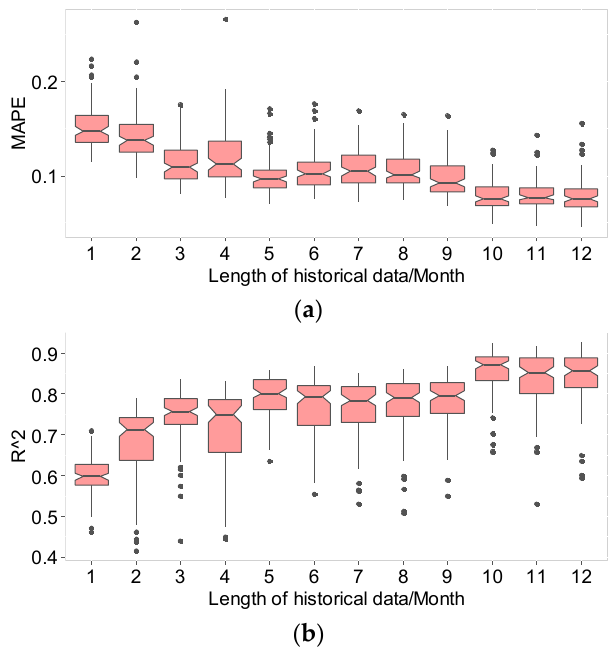
Figure 13. The distribution of the DPVS capacity estimation results for different length of historical data ( a ). MAPE ( b ) R 2